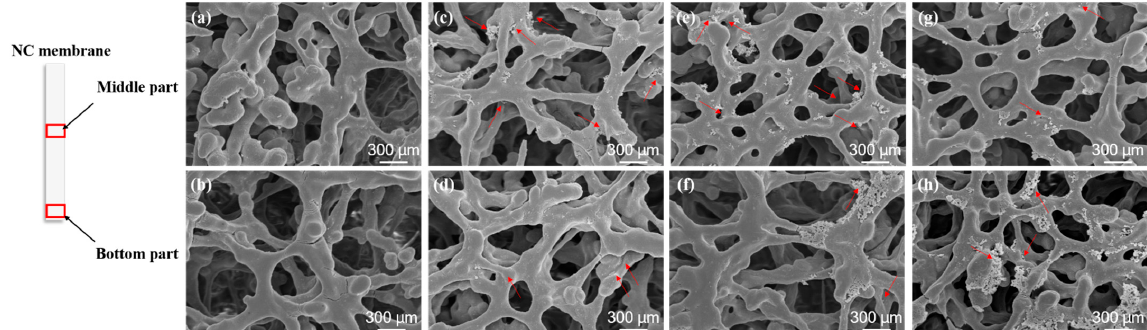
Figure 5. Characterization of CoFe 2 O 4 nanozymes on NC membrane by SEM. ( a ) Middle part of blank NC membrane. ( b ) Bottom part of blank NC membrane. ( c ) Middle part of CoFe 2 O 4 -1-NC membrane. ( d ) Bottom part of CoFe 2 O 4 -1-NC membrane. ( e ) Middle part of CoFe 2 O 4 -2-NC mem- brane. ( f ) Bottom part of CoFe 2 O 4 -2-NC membrane. ( g ) Middle part of CoFe 2 O 4 -3-NC membrane. ( h ) Bottom part of CoFe 2 O 4 -3-NC membrane. Red arrows are used to point out the nanozymes.